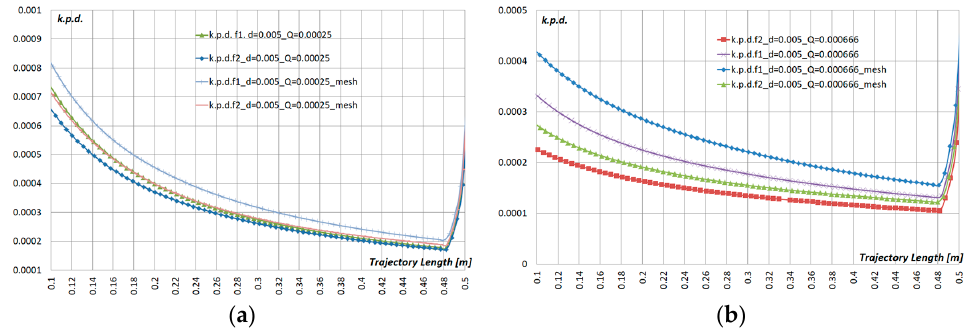
Figure 10. Atomization efficiency η , d = 500 µm: ( a ) Q = 0.00025 m 3 /s; ( b ) Q = 0.000666 m 3 /s.